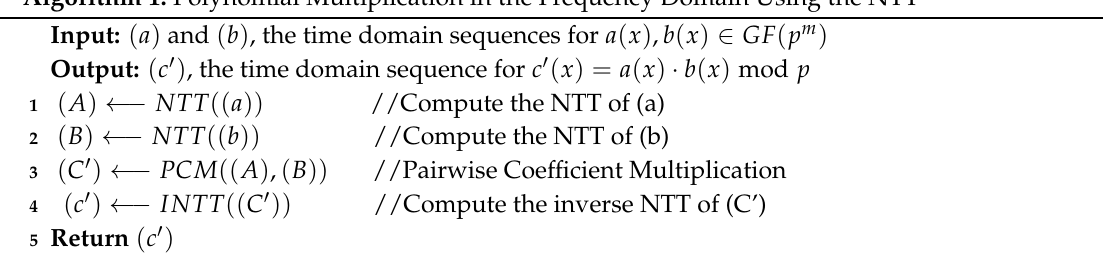
Algorithm 1: Polynomial Multiplication in the Frequency Domain Using the